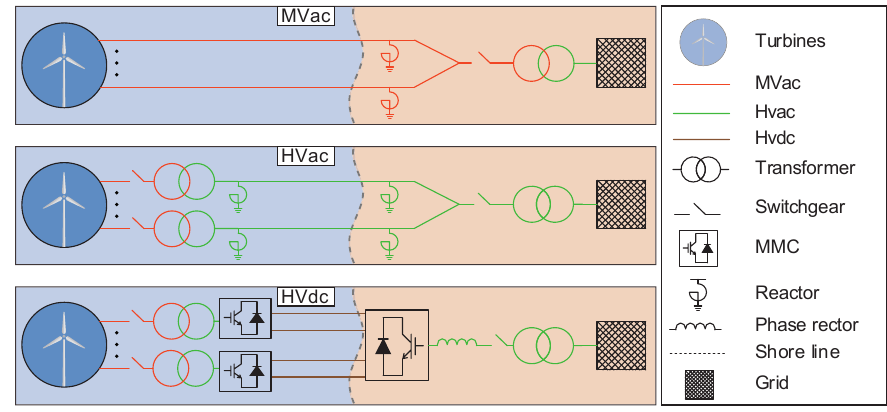
Figure 15. Electrical infrastructures considered in the optimization